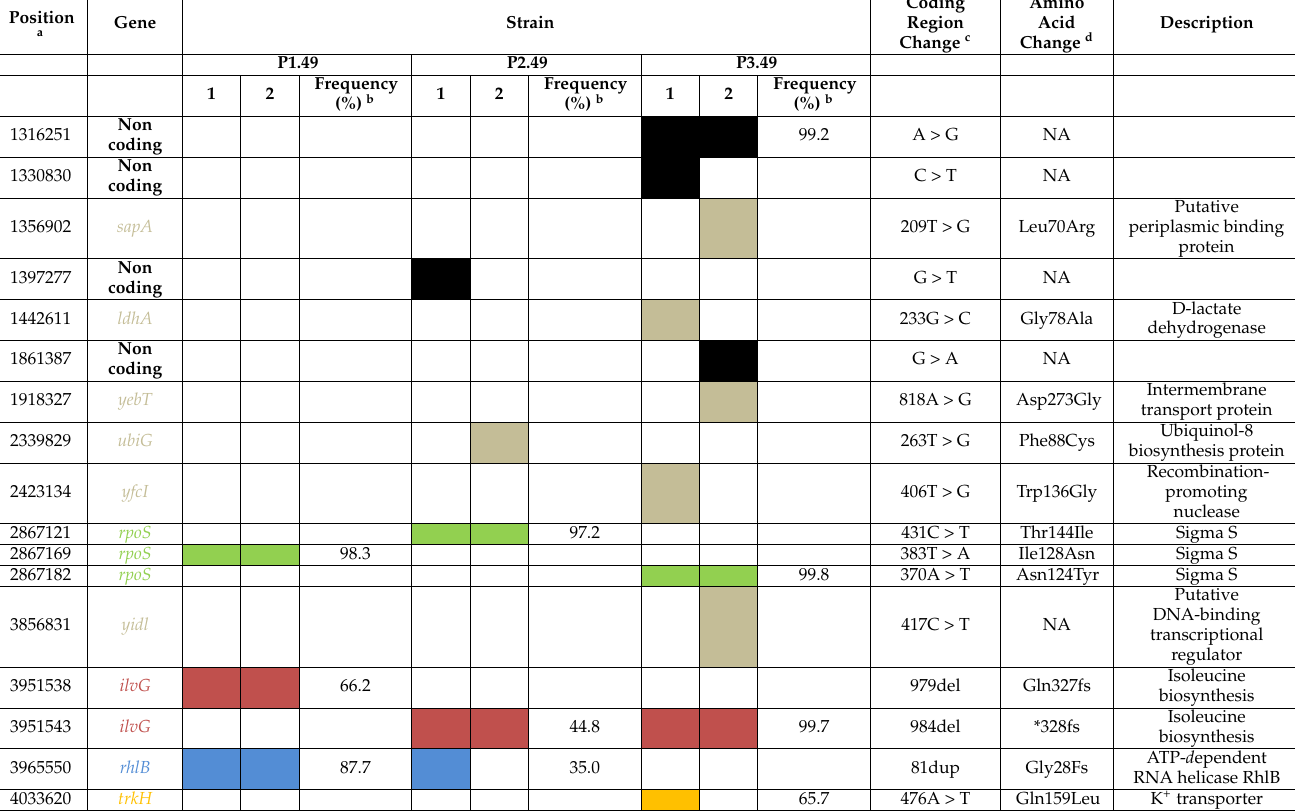
Table 2. Mutations identified in selected clones and populations after adaptation in deuterated minimal medium with sodium pyruvate- h 3 .